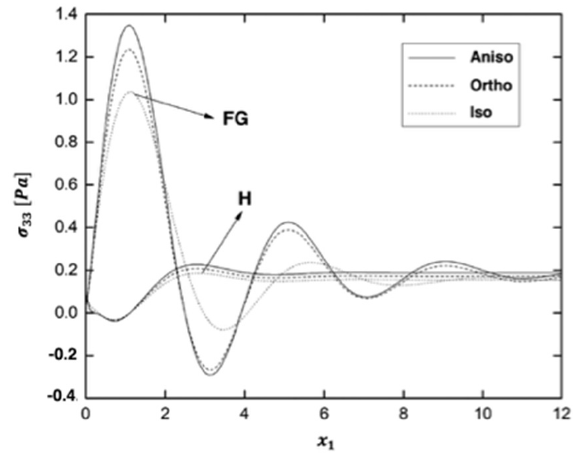
Figure 13. Variation of the thermal stress wave σ 33 along x 1 − axis in the functionally graded (FG) and homogeneous (H) fiber-reinforced plates for different materials.